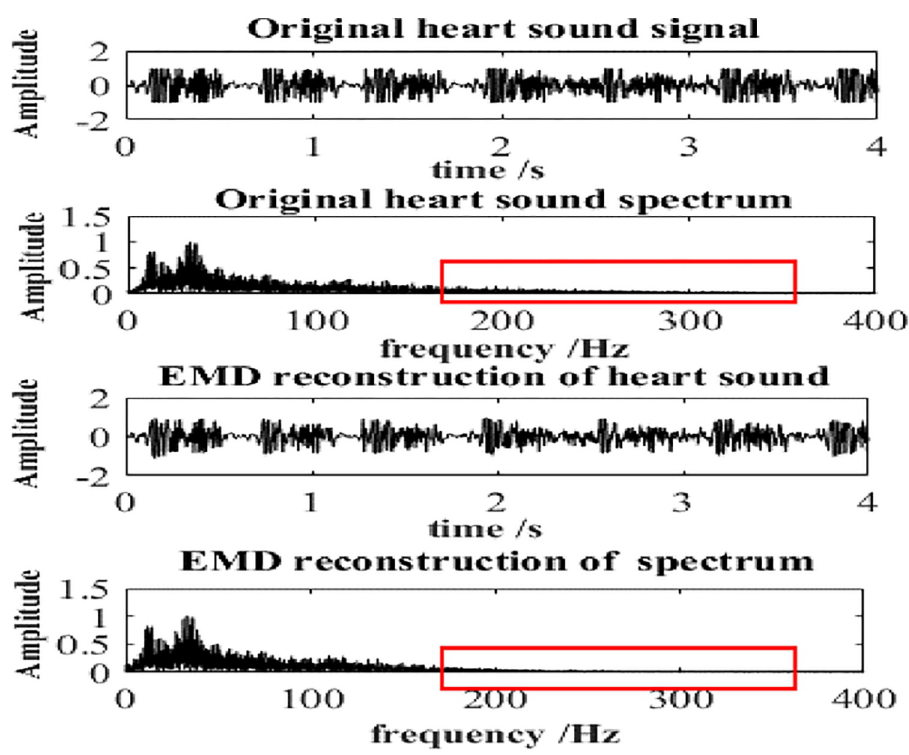
Fig 8. Time-frequency of heart sound EMD